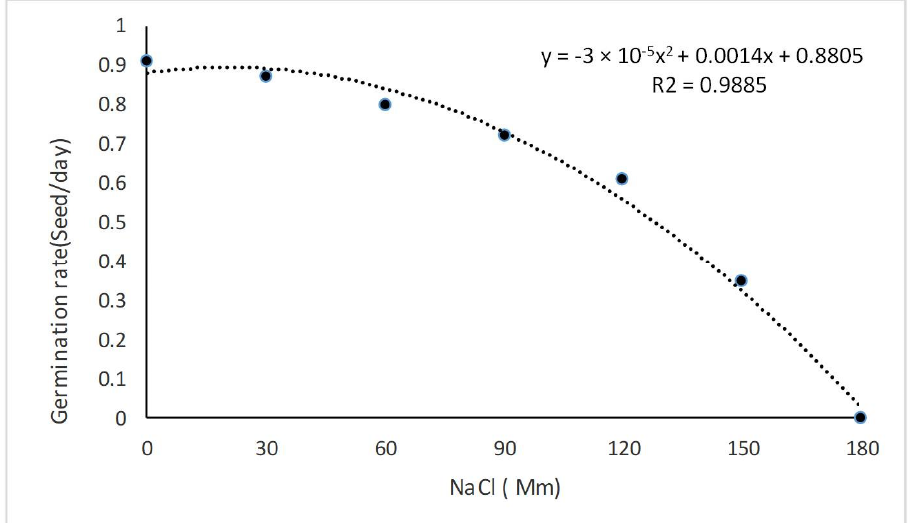
Figure 3. Effects of salinity stress on the GR of Hibiscus tea seeds.